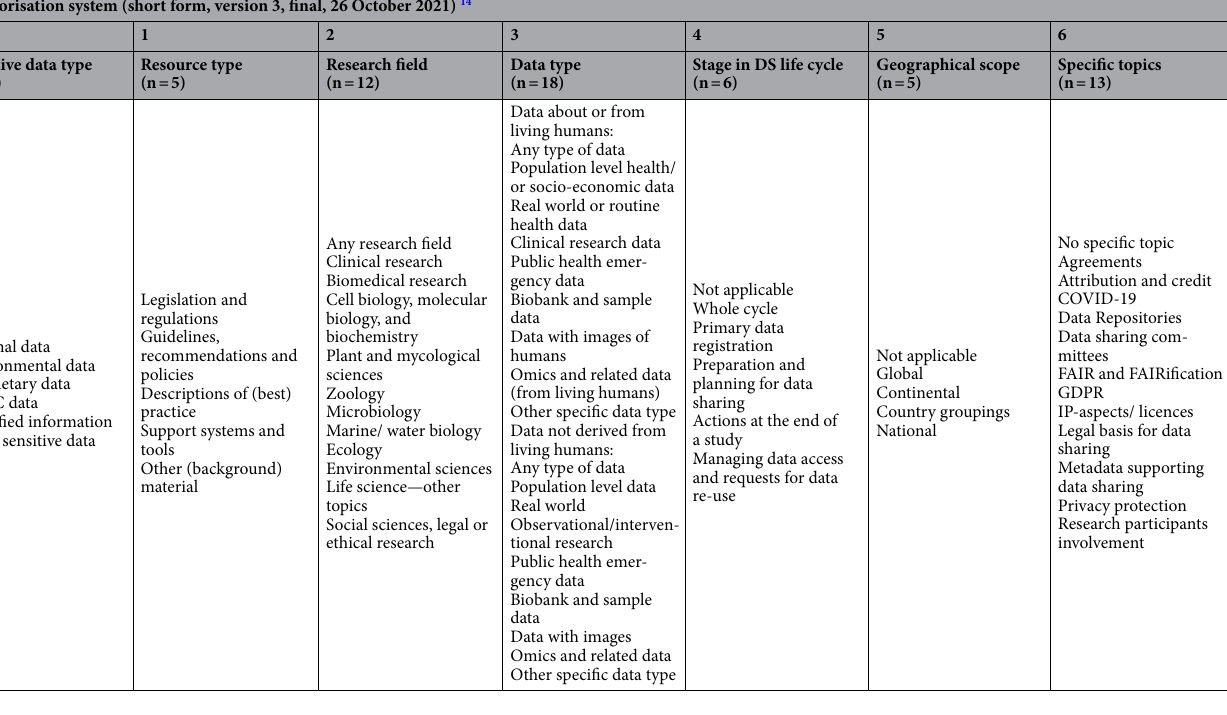
Table 3. Categorisation system version 3 (short version) 14